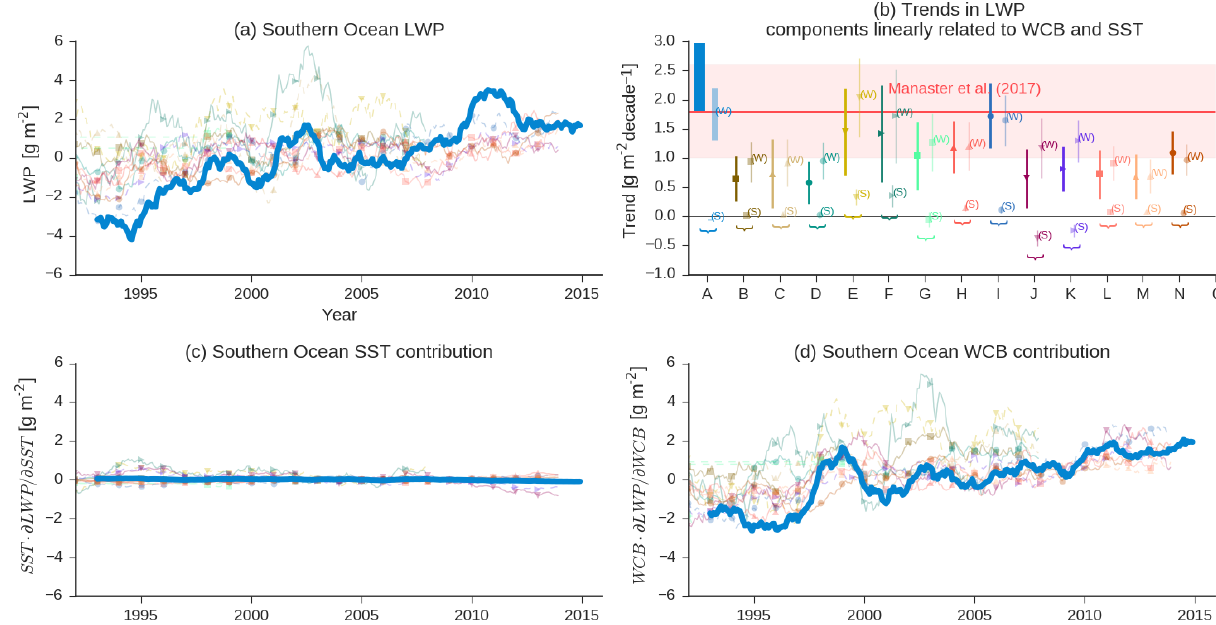
Figure 4. (a) SH cyclone LWP RM in observations (thick blue line) and models (colors as in Fig. 1) for which cyclones are centered between 44.5 and 59.5 ◦ S. A 2-year running mean has been applied to simplify the plot. (b) The red shaded area shows the zonal-mean Southern Ocean LWP trend calculated in Manaster et al. (2017) (Southern Ocean defined as 44.5–59.5 ◦ S therein). Trends in cyclone LWP RM from observations and models are shown in dark colors (where LWP RM is calculated using cyclones centered in the same region as Manaster et al., 2017). Models and observations are labeled by a letter on the ordinate (see Table 2). Observations are labeled as “A”. The 95% confidence in each trend is shown using error bars. A multiple linear regression of LWP CM on SST CM and WCB moisture flux is used to partition the trend into contributions from WCB and SST changes. The trend in LWP RM predicted by the regression model (Eq. 4) and changes in SST RM are shown in (c) , and the trend in LWP RM associated with WCB is shown in (d) . The trend from models and observations consistent with their multiple linear regression models and changes in SST RM and WCB are shown in (b) using lighter colors and labeled as (S) for SST and (W) for